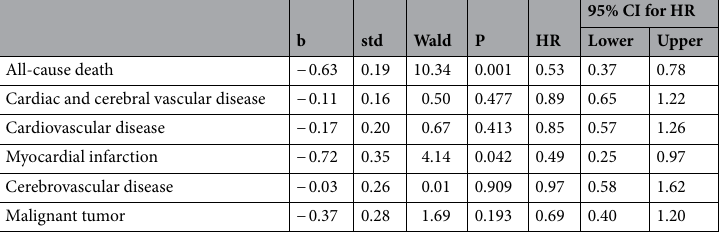
Table 6. Cox regression of the effect of acarbose therapy on various endpoint events in BCDS study.